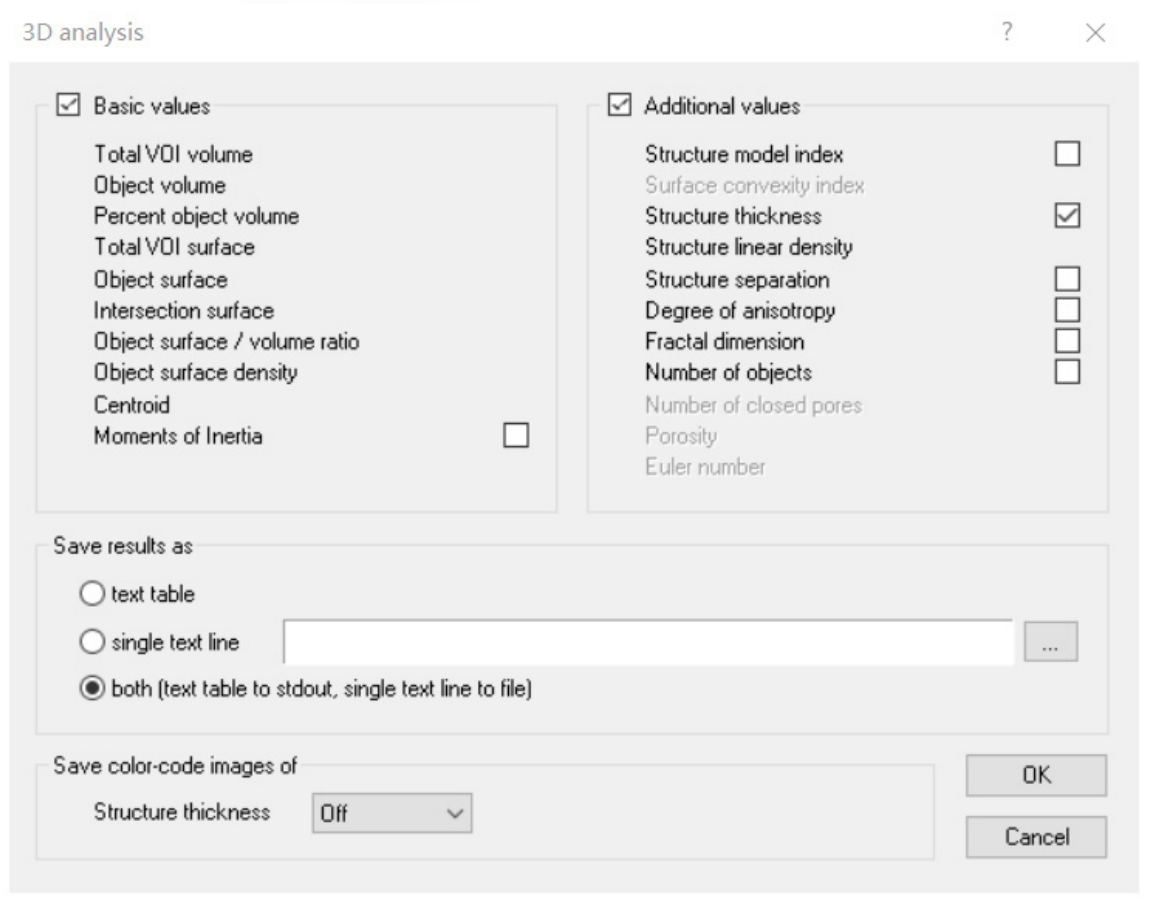
Figure 6. Operation interface in 3D analysis procedure of adipose tissue in CTAn software.